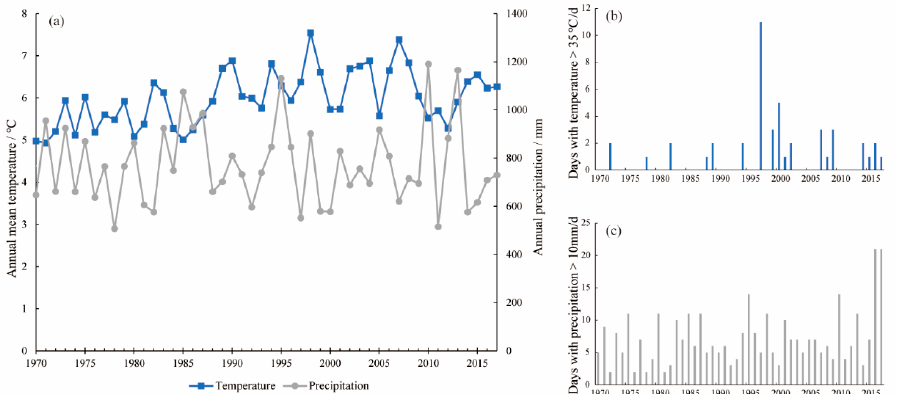
Figure 3. Variation of annual average temperature and annual precipitation ( a ), days with temperature above 35 °C ( b ), days with precipitation above 10 mm ( c ) in Qingyuan from 1970 to